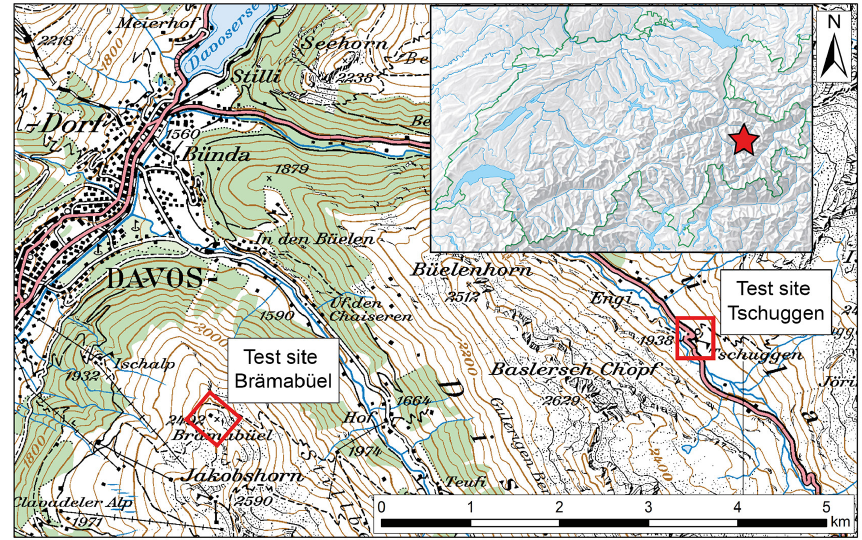
Figure 1. Location of test sites Tschuggen and Brämabüel close to Davos, Switzerland; Pixmap © 2015 swisstopo (5704000000), reproduced by permission of swisstopo